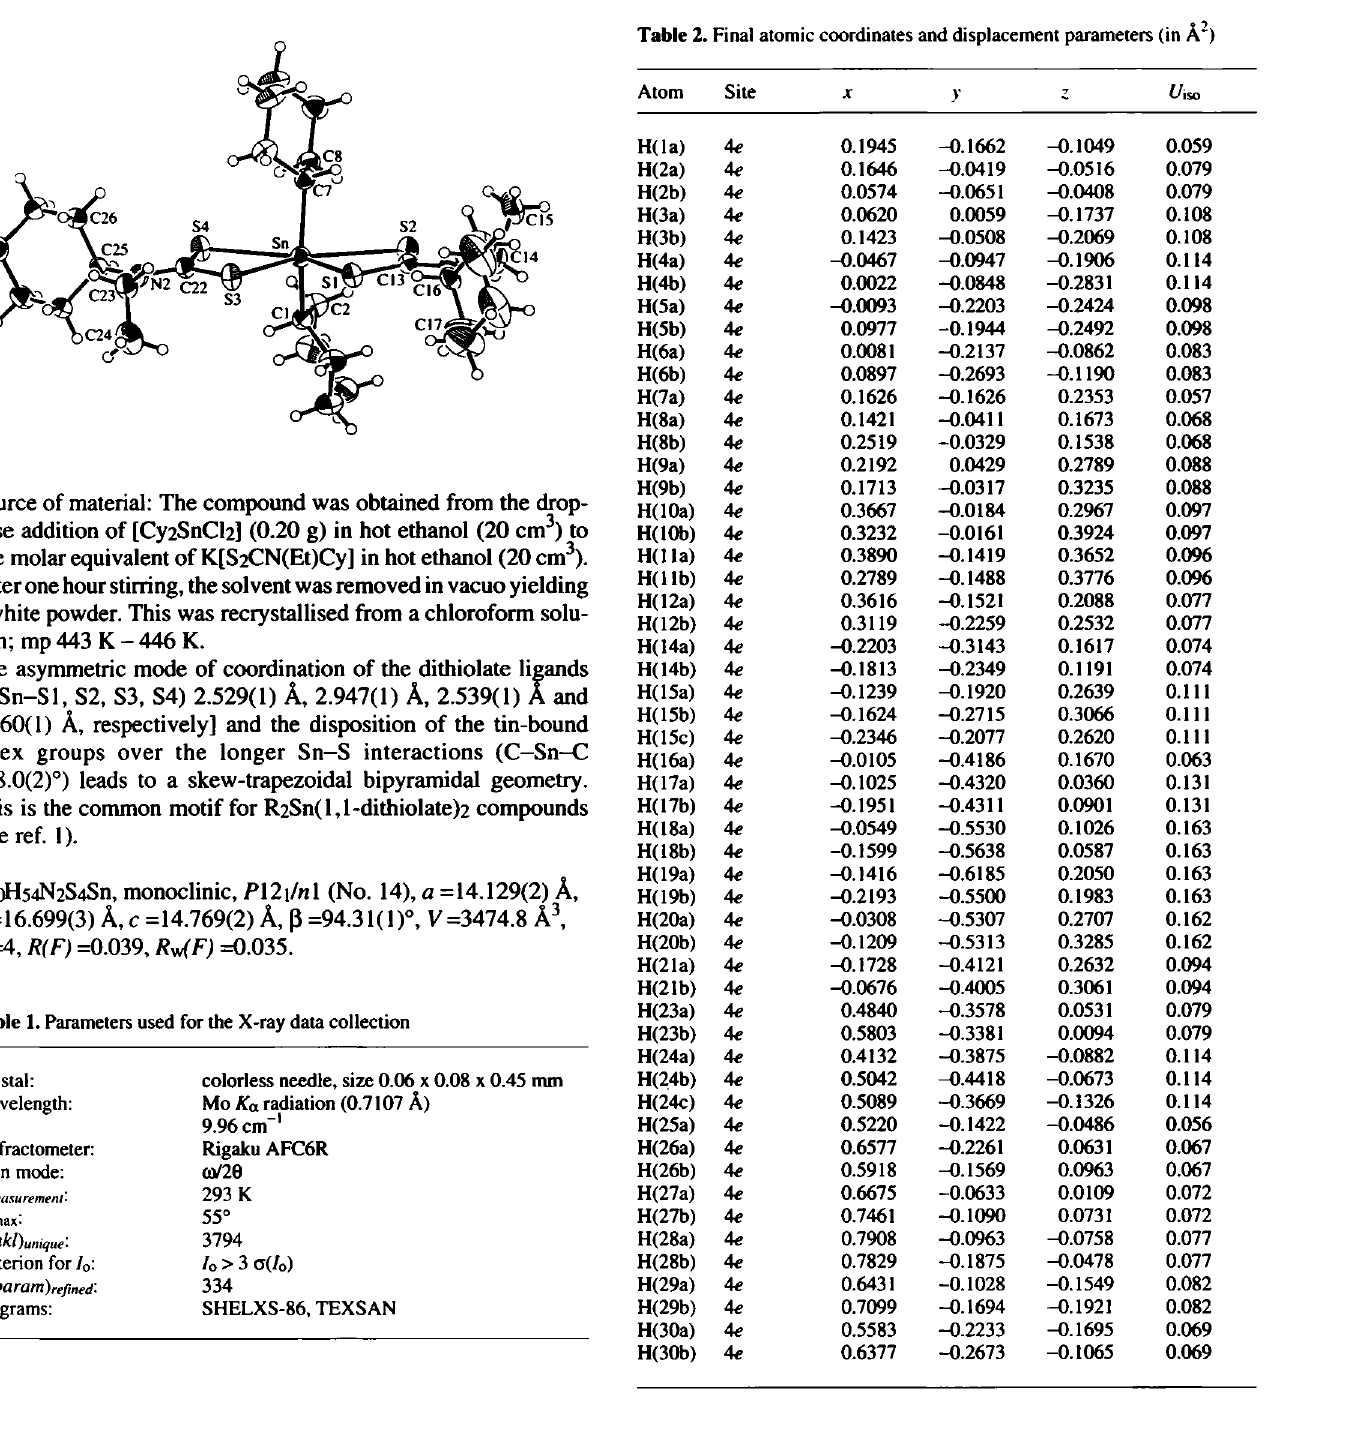
Table 2. Final atomic coordinates and displacement parameters (in Â') Atom